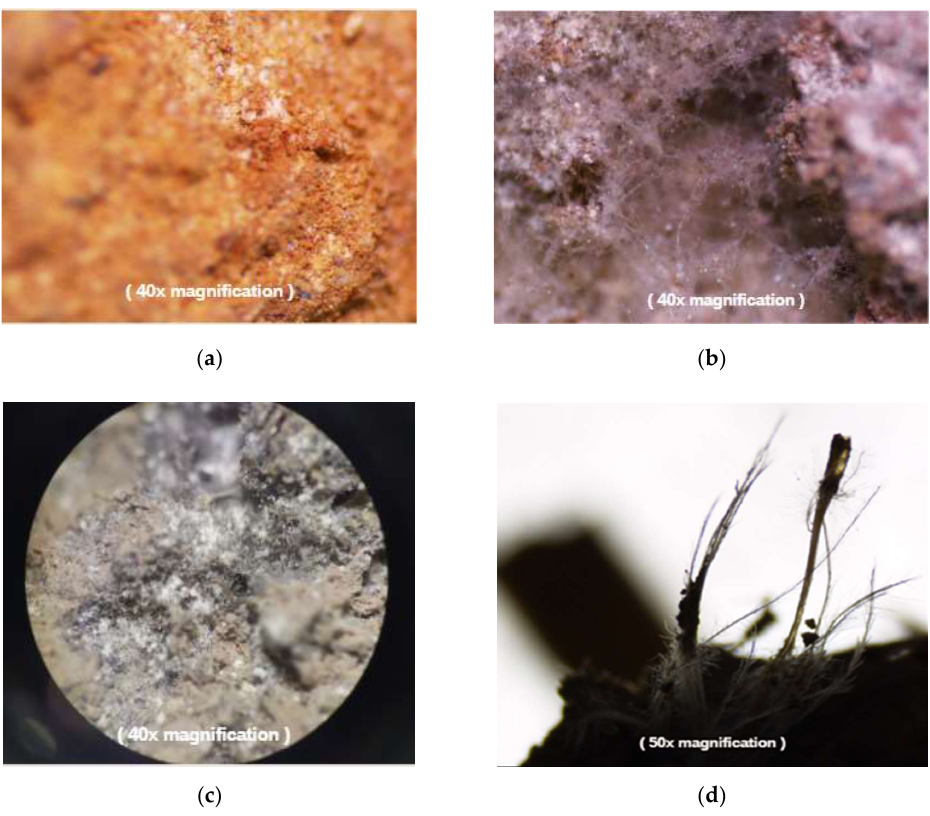
Figure 12. Stereoscopic images for: ( a ) Clay with mycelium (CM); ( b ) sawdust with mycelium (SDM); ( c ) rice bran with mycelium (RBM); ( d ) sawdust with mycelium (SDM).